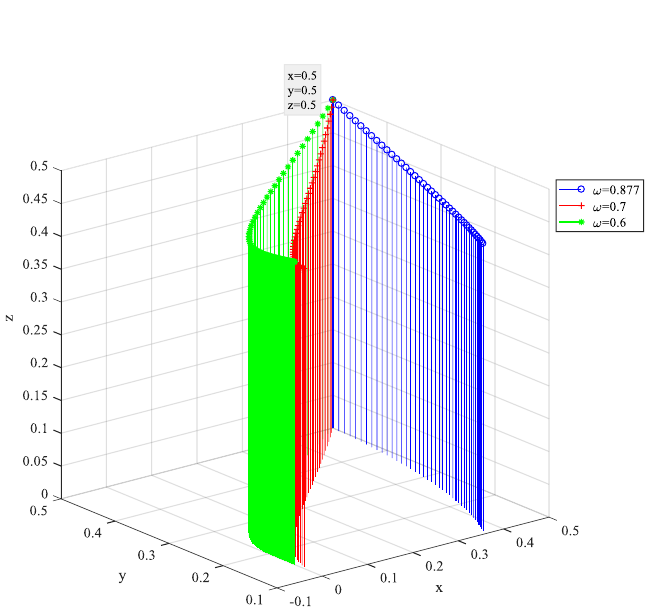
Figure 17. Behavior evolution of three players under different discount coefficient ω